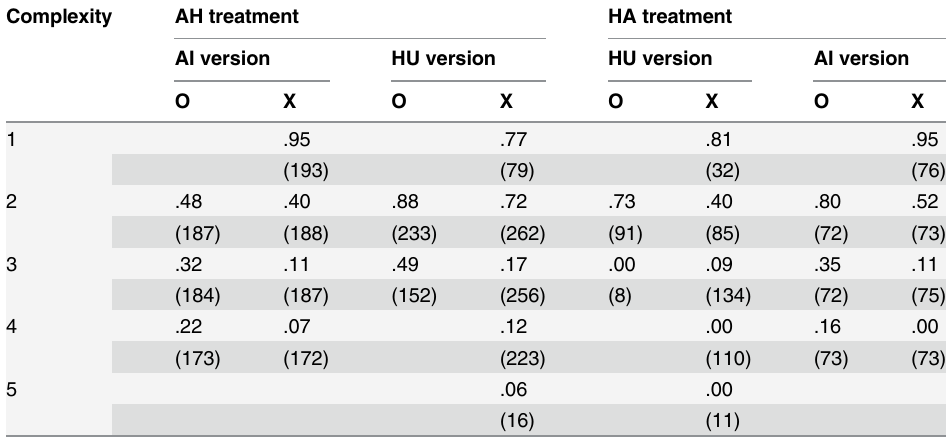
Table 8. Solved df games by treatment. Observations in parenthesis.